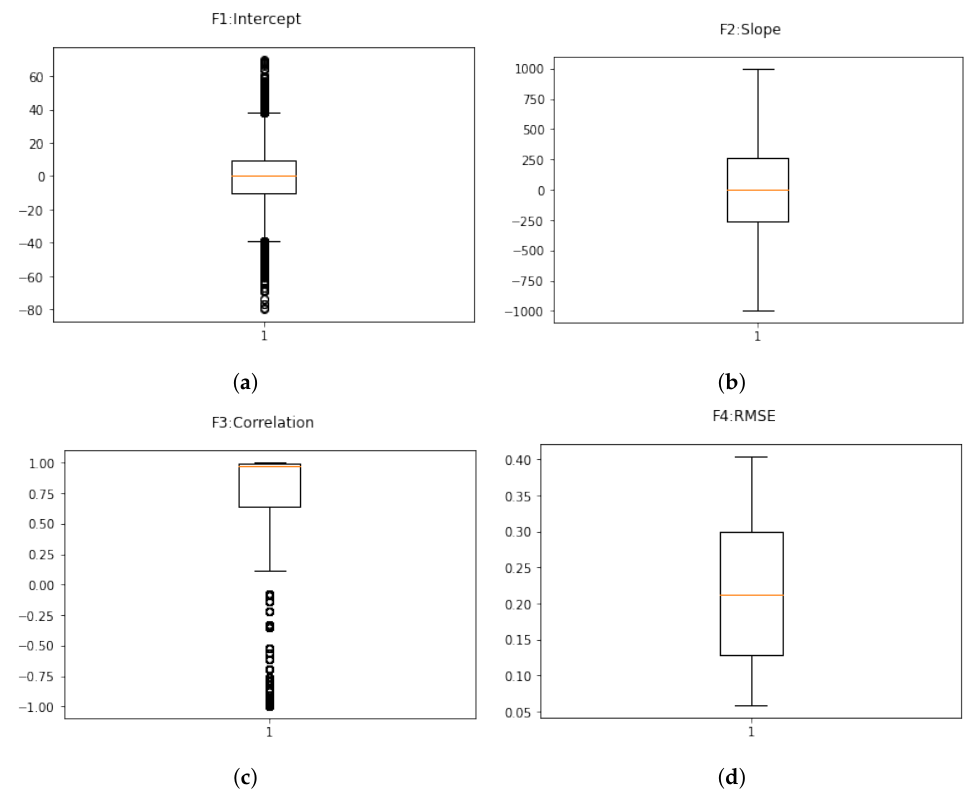
Figure 8. Box plot for each input feature in Dataset-2 (THD level from 10% to 50%) ( a ) m. ( b ) c. ( c ) R.